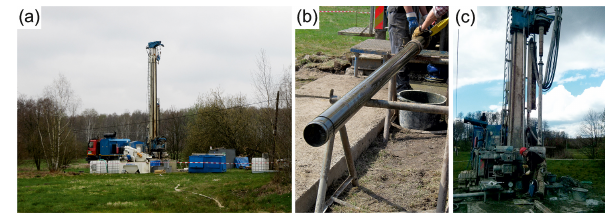
Figure 7. (a) Drill site of HJB-1 in Hartouˆsov; (b) core barrel dis- play after recovery; (c) geophysical logging